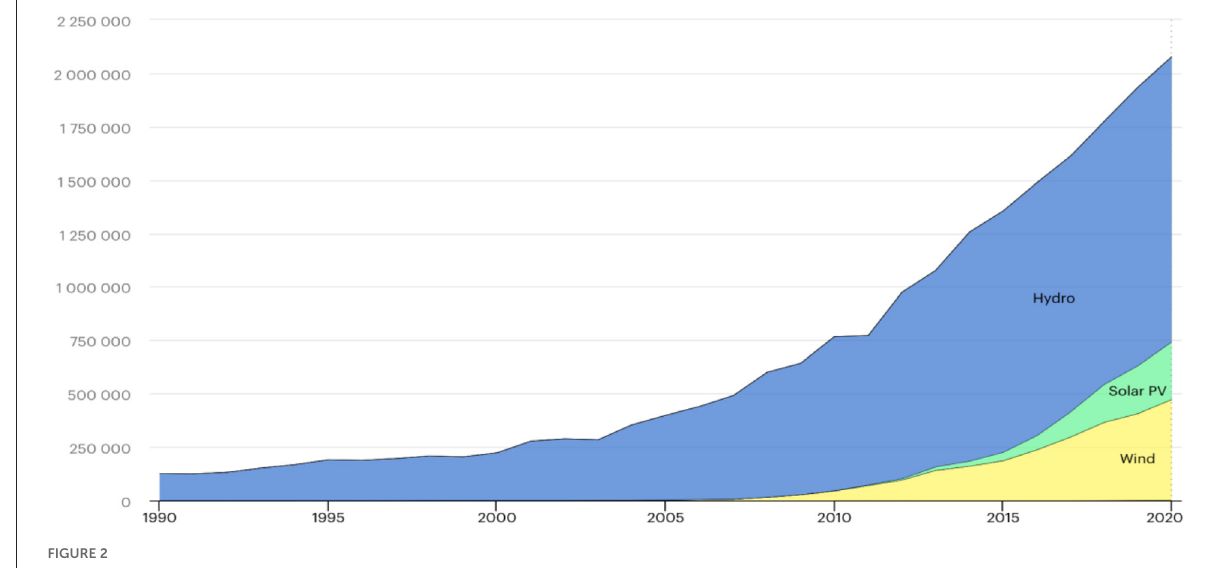
FIGURE2 Renewable energy production. Source: ( 17).